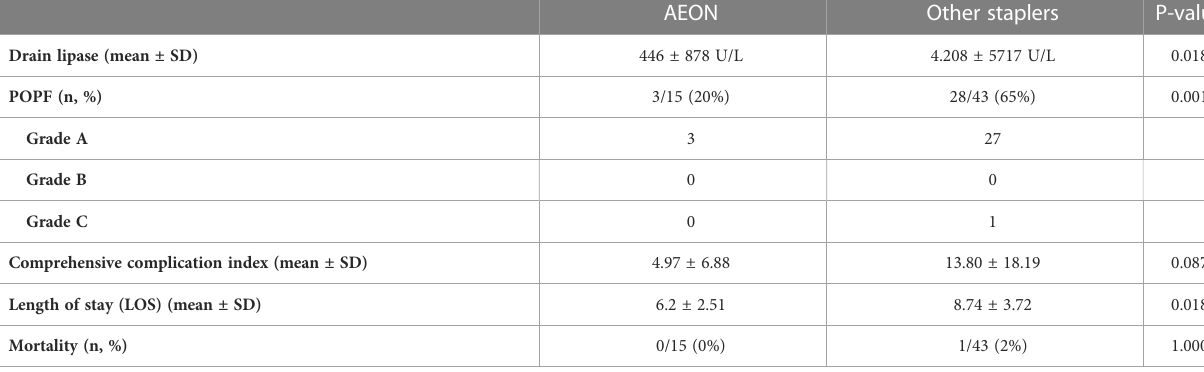
TABLE 2 Postoperative outcome comparison between AEON and other instrument used for pancreatic